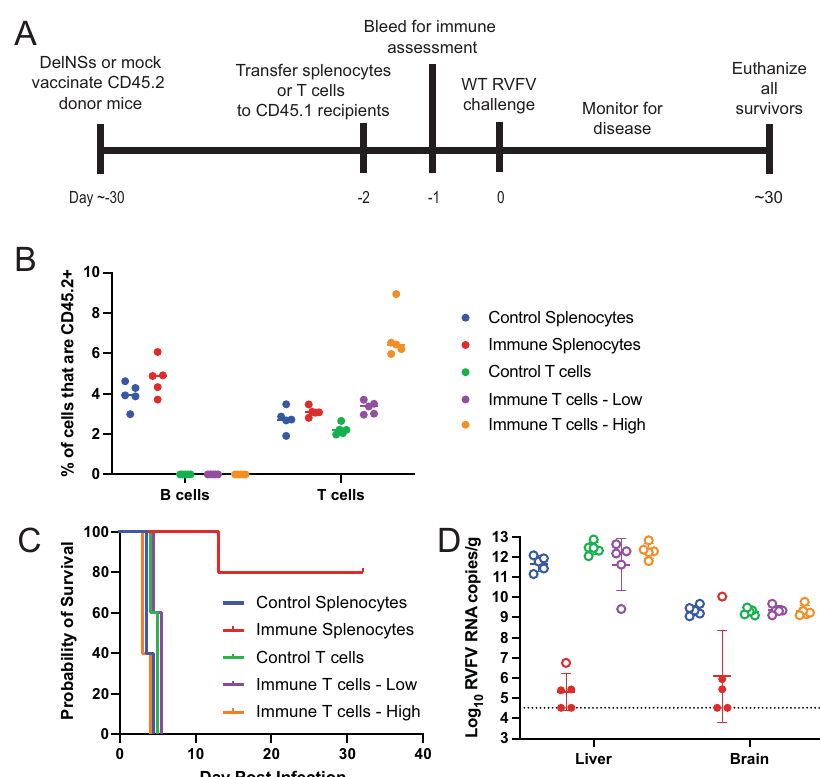
Fig. 4 Adoptive transfer of splenocytes from vaccinated animals provides protection from WT challenge. Naïve CD45.2 mice ( n = 5 per experimental group) were vaccinated with 2 × 10 5 TCID 50 of DelNSsRVFV or mock-vaccinated. Control or immune total splenocytes or T cells were harvested and transferred to naïve CD45.1 recipient mice ( A ). Recipient mice received immune splenocytes, control splenocytes, control T cells, or immune T cells at low (1 × 10 7 ) or high (2.6 × 10 7 ) concentrations. The number of donor-derived (CD45.2) B cells and T cells present in the blood of recipient animals one day after transfer was determined by fl ow cytometry ( B ). Mean values are noted. Mice were subsequently challenged with 2 TCID 50 WT RVFV and monitored for survival ( C ). Viral RNA loads were determined at the time of euthanasia ( D ). Open circles represent animals that died or required euthanasia while closed circles represent animals that survived. The dotted line is the LOD of the assay. Geometric means and geometric standard deviation are